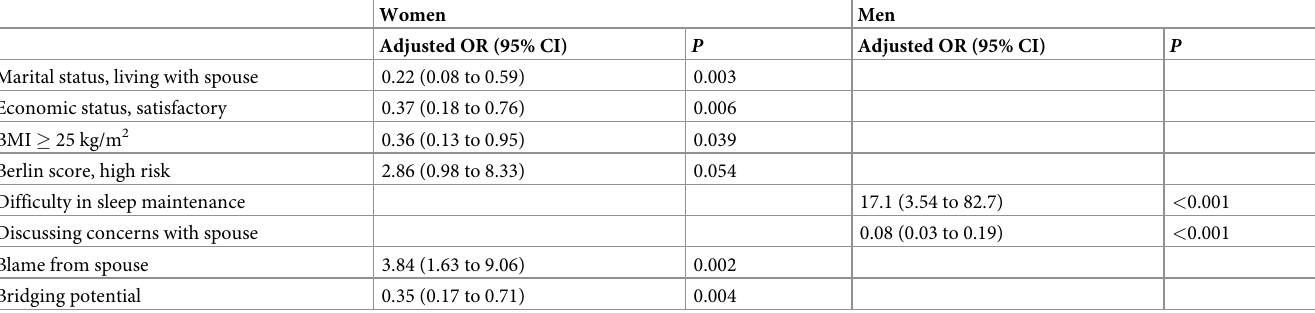
Table 2. Factors associated with total sleep time